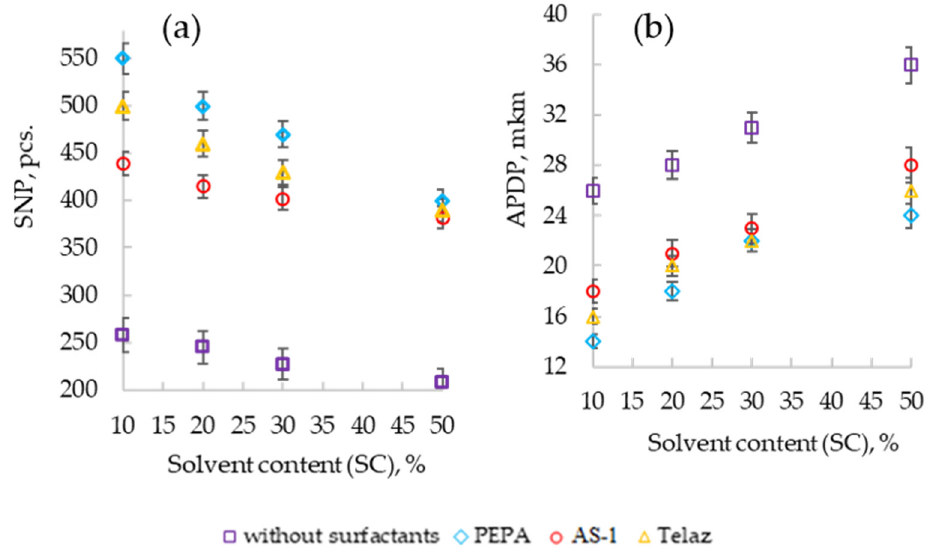
Figure 4. Effect of the surfactant type on APDP ( a ) and SNP ( b ) at CS = 0.25 g/dm 3 . With an increase in the solvent content in the composition, computer-optical microscopy revealed a deterioration in the dispersion of the pigment, expressed in an increase in the diameter of the pigment particles (APDP) Figure 4a and a decrease in their number (SNP) Figure 4b.